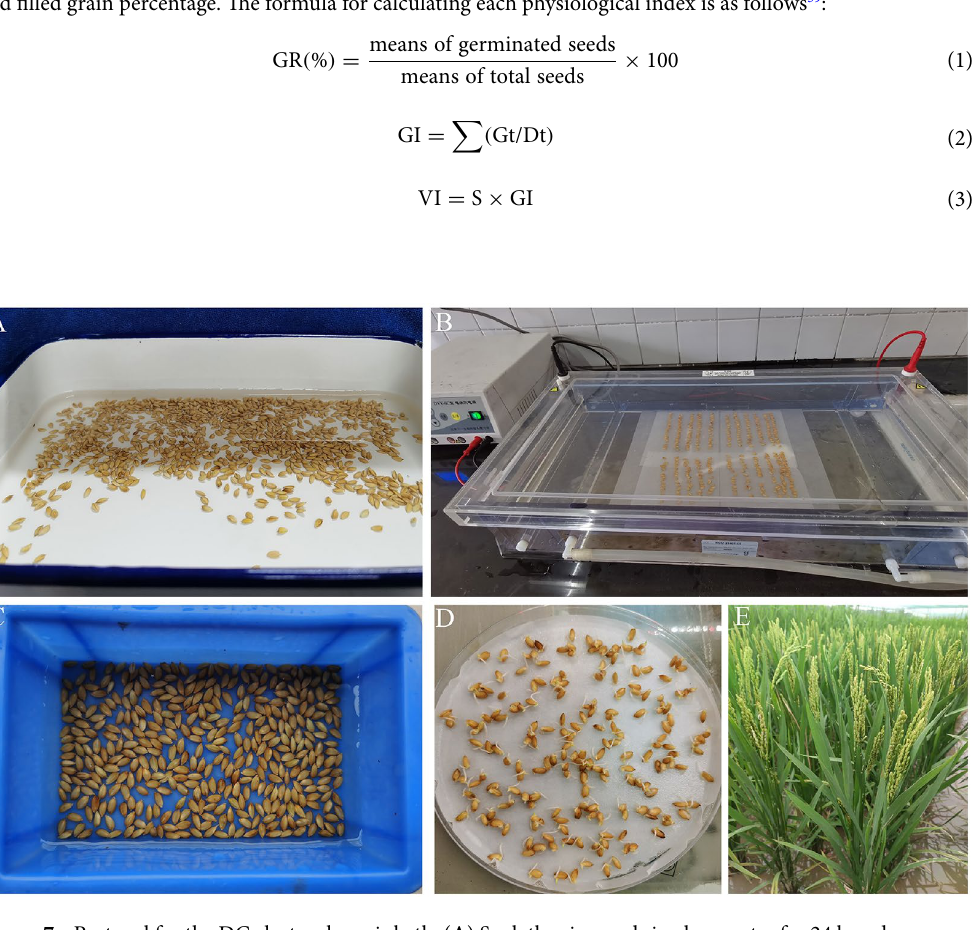
Figure 7. Protocol for the DC electrophoresis bath. ( A ) Soak the rice seeds in clean water for 24 h and disinfected with 3–6% sodium hypochlorite for 30 min; ( B ) the soaked and disinfected seeds were placed in an electrophoresis tank lined with filter paper and buffer, and then start the DC electrophoresis for a certain period of time; ( C ) After electrophoresis, the buffer residue was removed by washing with water; ( D ) Seeds were placed on petri dishes lined with filter paper for germination, and ( E ) Seedlings from these germinated seeds were transplanted to the